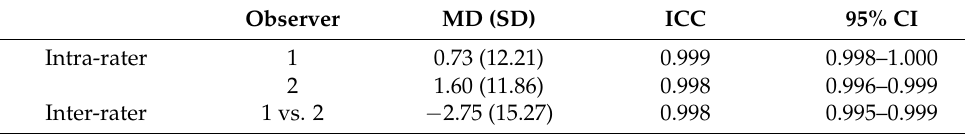
Table 2. Intra-rater and inter-rater reliability of volume measurements.